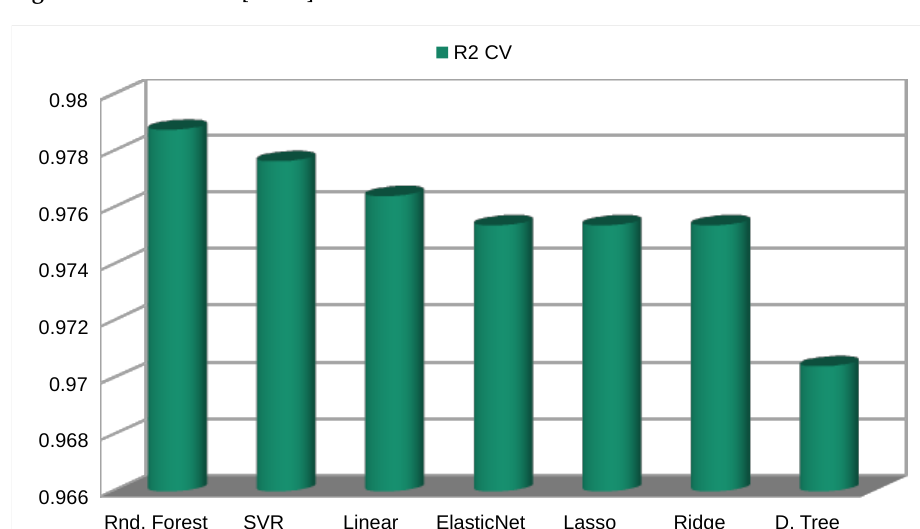
Figure 6. Model errors [ms − 1 ].